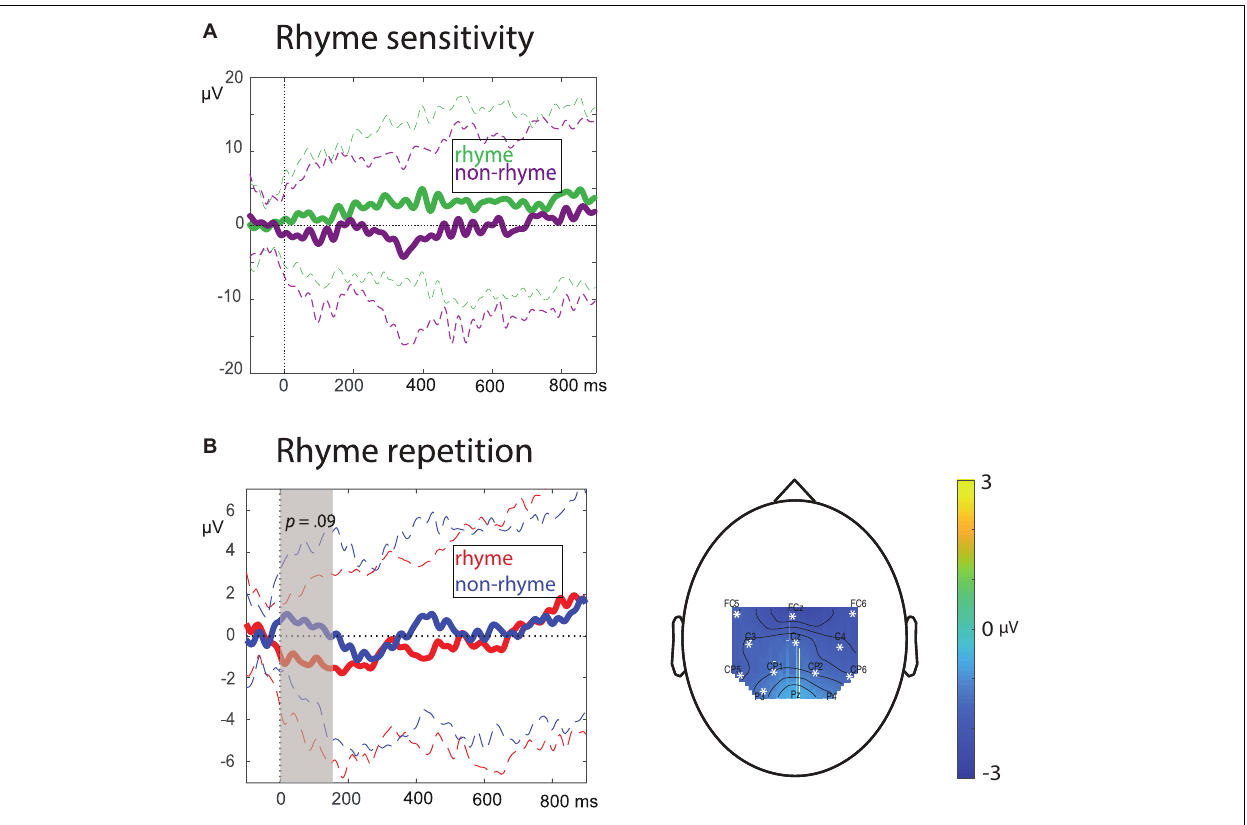
FIGURE 2 | Rhyme sensitivity effect (based on the final pseudo-word of phrase 2 of every song, n = 18 infants) and Rhyme repetition effect (based on the final pseudo-words of phrase 3–10 of the songs, n = 28 infants). Solid lines = Means; dotted lines = ± 1 SD; (A) : ERPs, averaged over all 13 electrodes; (B) left: ERPs averaged over the electrodes in the largest identified cluster (0–178 ms, p = 0.09), right: topographic isovoltage maps of the difference between rhyme and non-rhyme within the rhyme repetition effect cluster time window (0–178 ms) for all tested electrodes, cluster electrodes are marked with white